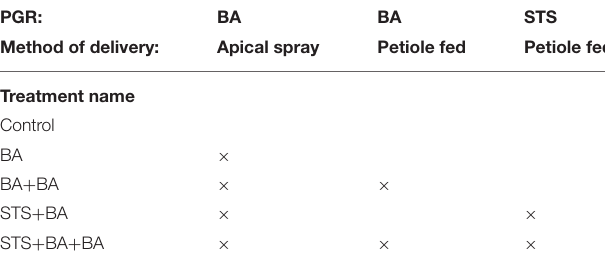
TABLE 2 | Summary of PGR treatments for experiment